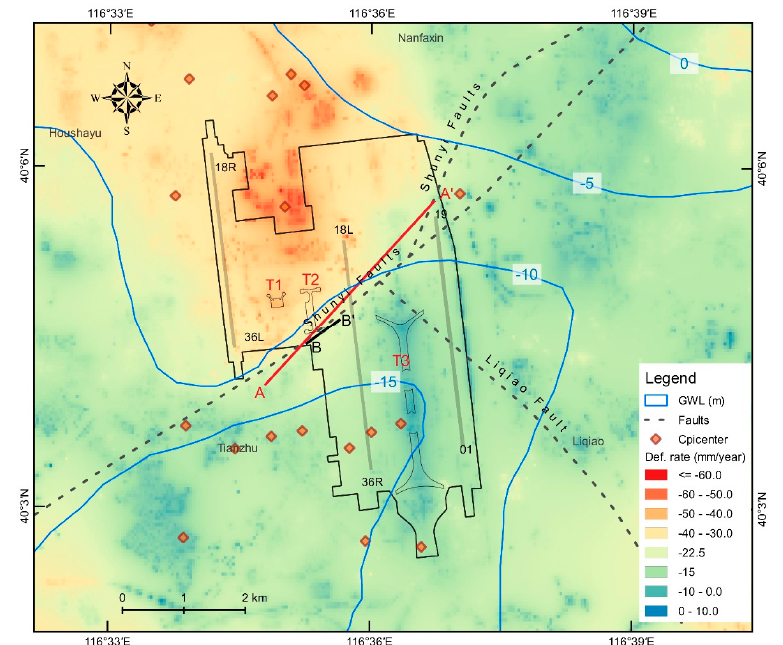
Figure 11. The distribution of the quaternary sedimentary types, groundwater level (GWL), and active